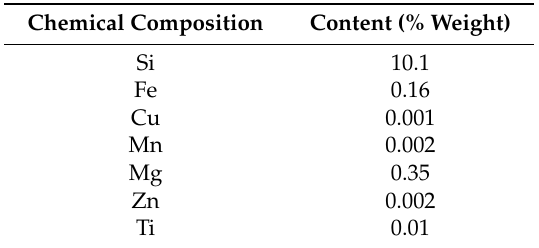
Table 1. Chemical composition (% weight) of the alloy.